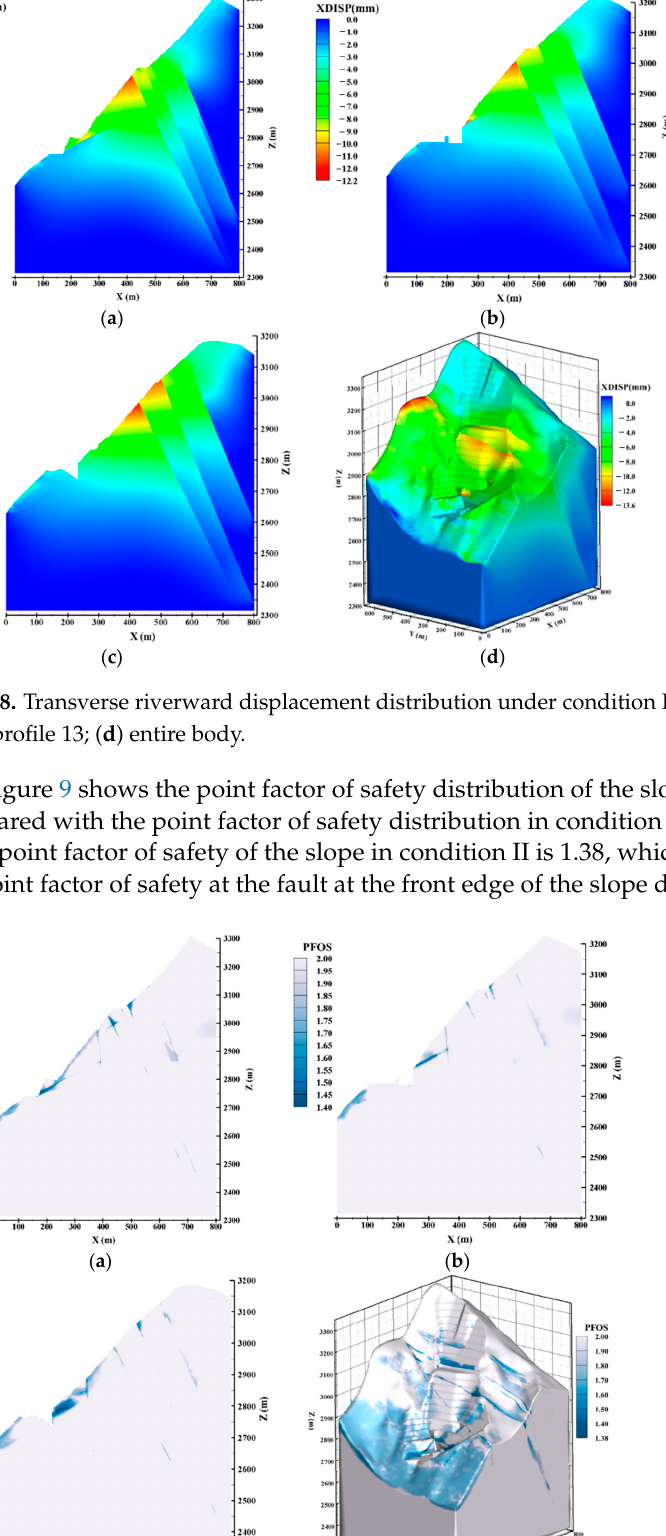
( d ) Figure 7. Point factor of safety distribution of slope under condition I. ( a ) Profile 5; ( b ) profile 10; ( c ) profile 13; ( d ) entire body.